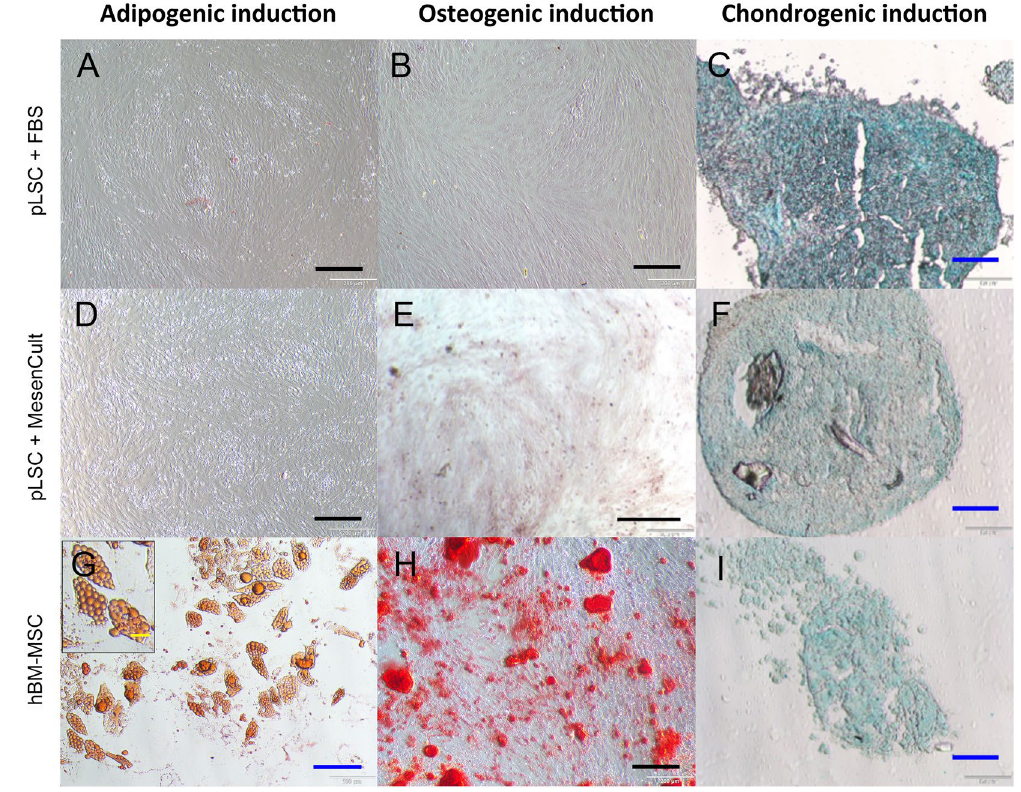
Figure 4. Differentiation of pLSCs and hBM-MSCs into adipogenic ( A,D,G ), osteogenic ( B,E,H ), and chondrogenic ( C,F,I ) lineages. Adipogenic and osteogenic differentiation occurred in BM-MSC cultures but not in pLS, as confirmed by Oil Red O and Alizarin Red staining respectively (left and center column). Chondrogenesis differentiation was observed in all conditions as assessed by Alcian Blue staining (right column). Black scale bar = 200 μ m, blue scale bar = 100 μ m, yellow scale bar = 20 μ